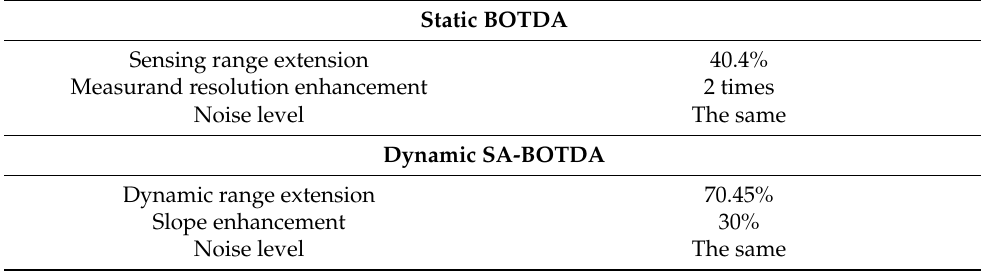
Table 1. Summary of the key benefits of spectrum engineering in BOTDA and SA-BOTDA in comparison to standard